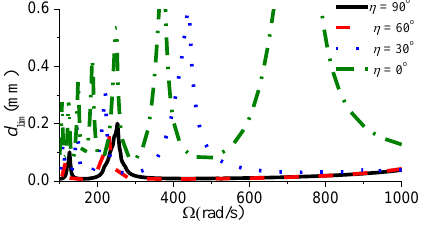
Figure 12. The influence of ply angle on stable zone.